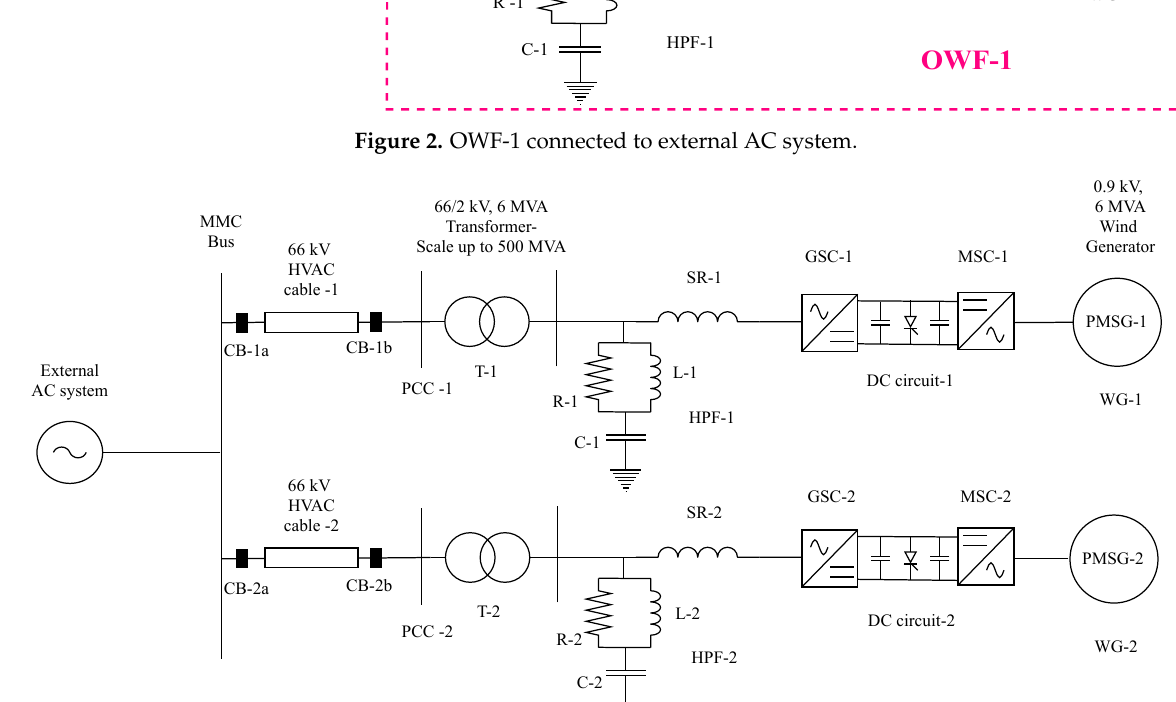
Figure 3. OWF-1 and OWF-2 connected in parallel to external AC